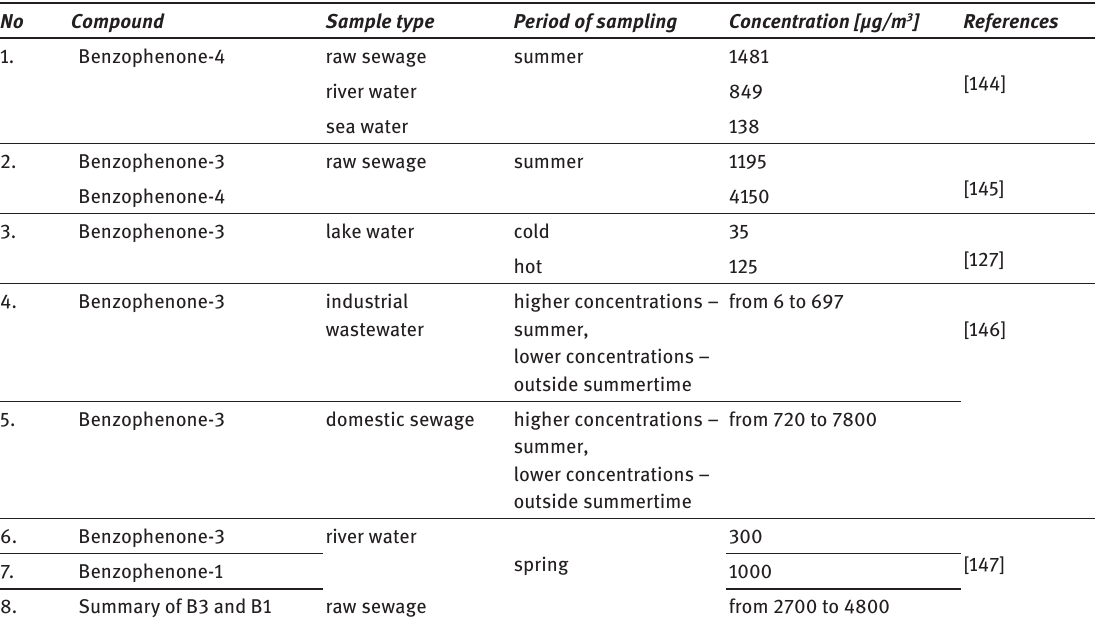
Table 2: Determined concentrations of benzophenones in environmental